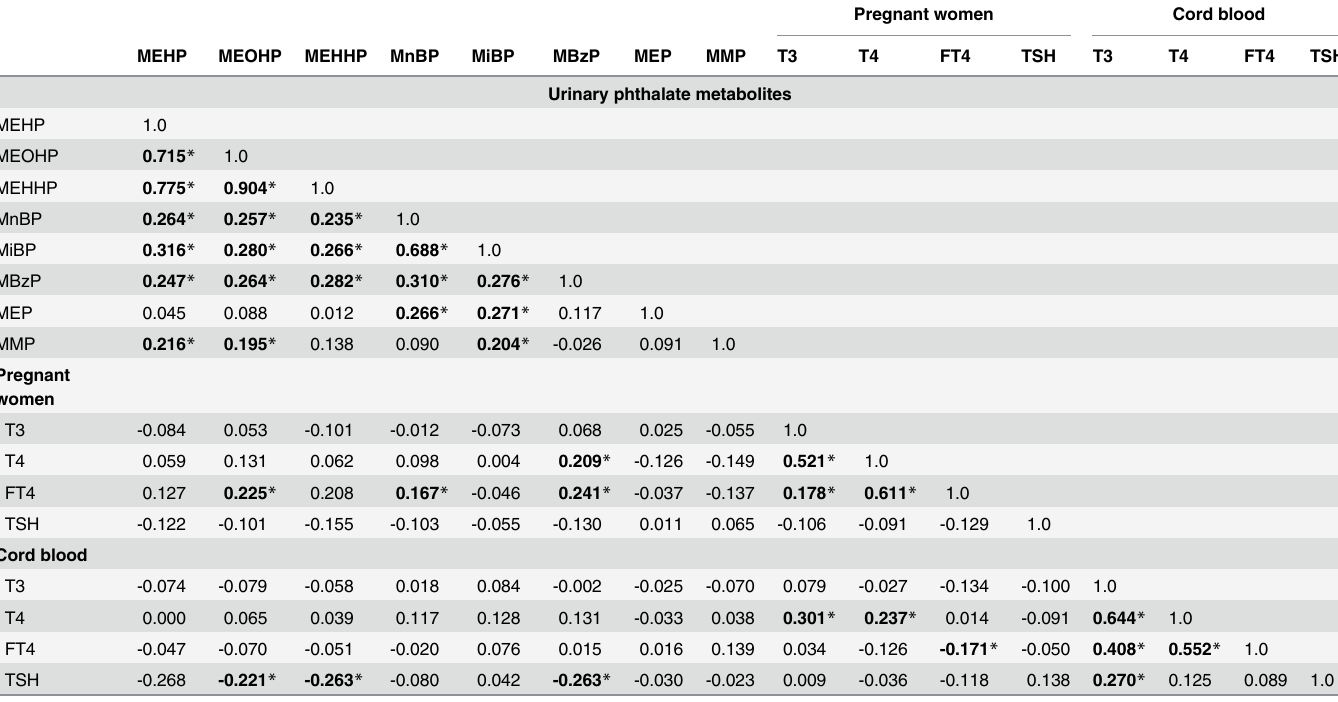
Table 3. Spearman correlation between urinary phthalate metabolites and serum thyroid profiles in pregnant women and cord